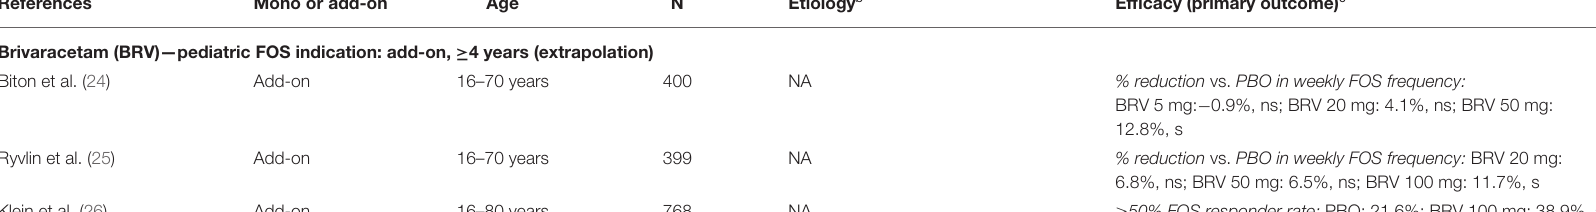
Brivaracetam (BRV)—pediatric FOS indication: add-on, ≥ 4 years (extrapolation) Biton et al.